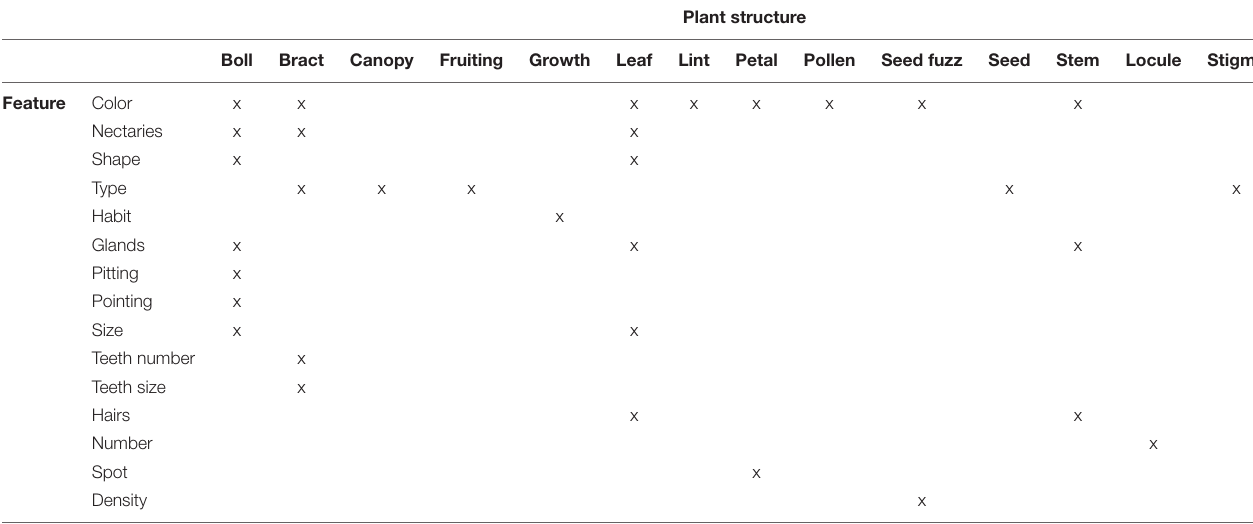
TABLE 1 | Summary of 33 phenotypic descriptors analyzed in this study. Each descriptor, as marked by x, reflects a combination of a feature and the plant structure where the feature was